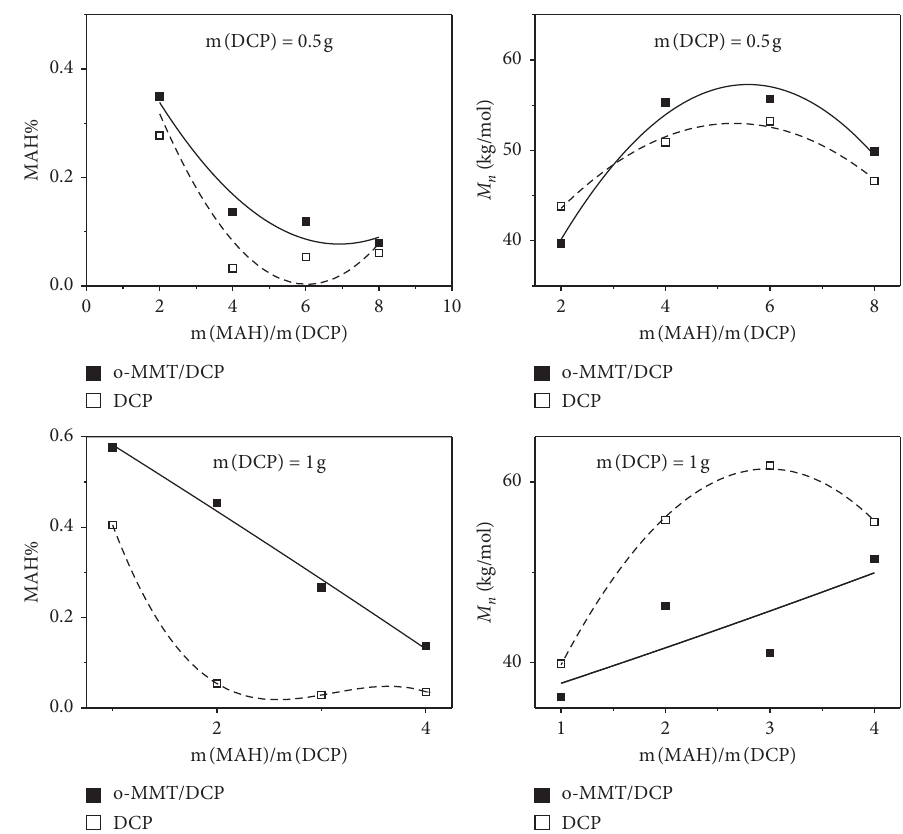
Figure 3: Comparison between the PP/DCP/MAH and PP/(DCP/o-MMT)/MAH grafting systems in terms of the evolution of the grafting degree and that of the molar mass of the PP-g-MAH as a function of the MAH content for a given DCP content.